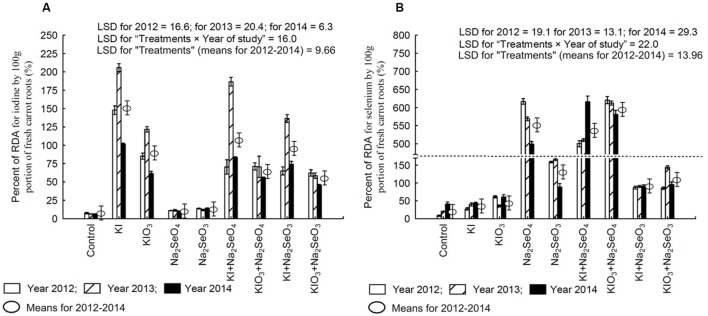
Percentage of Recommended Daily Allowance (RDA) for iodine (A) and selenium (B) in 100 g portion of fresh carrot roots in the years 2012–2014, depending on varying fertilization with iodine and selenium. The dotted line represents a break (shortening) of the scale on the Y-axis between 170 and 470. LSD, least significant difference, p < 0.05. Bars indicate standard error; (n = 4).